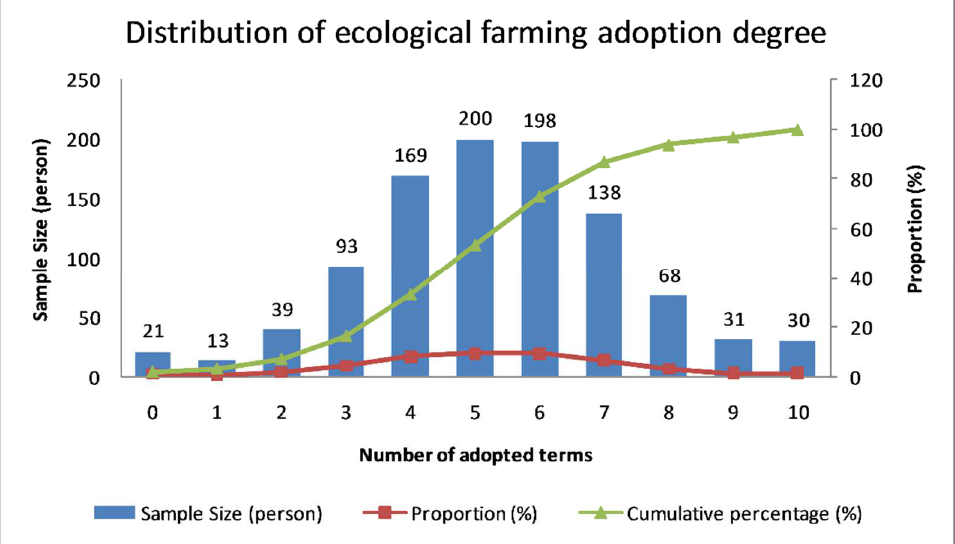
Figure 3. Distribution of ecological farming adoption degree.